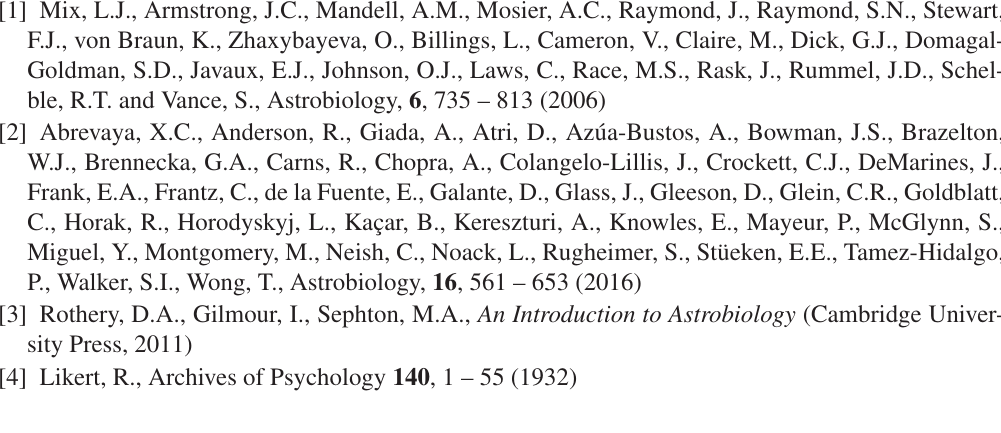
Figure 3. Describing the steps of solar and planet formation.